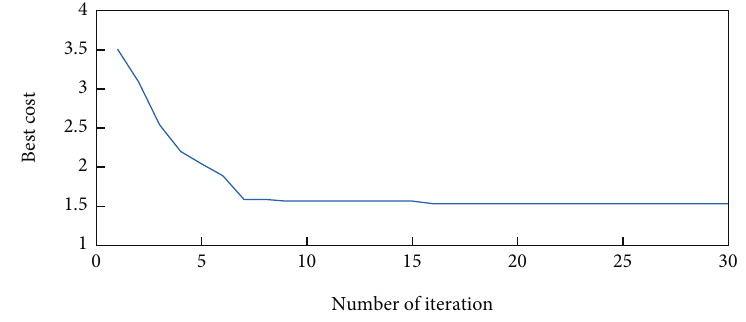
Figure 10: Optimal convergence of the PVE control system with the number of